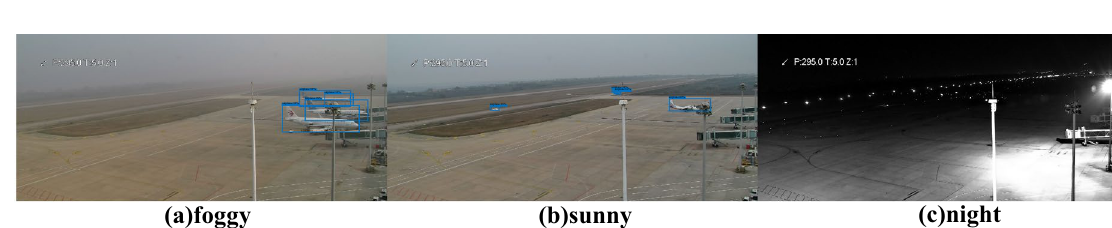
Figure 7. Faster-RCNN detection renderings in different scenarios.